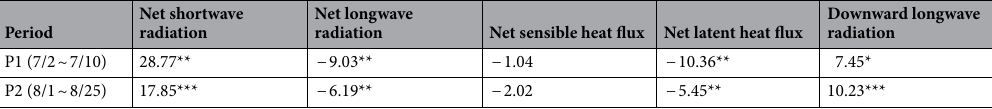
Table 3. Composite difference between HW-ASP (HWD) and NHW-ASP (HWD) for the surface energy budget components (units: W m −2 , positive: downwards, negative: upwards) over the ASP in P1 (July 2–July